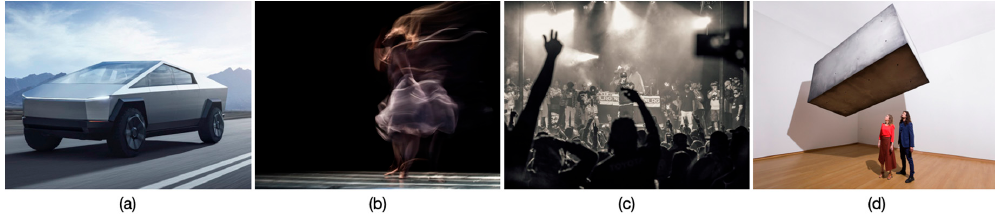
Figure 6. Examples suggested by the participants (Reprinted with permission): ( a ) Tesla cybertruck, ( b ) artist concert performance, ( c ) listening to music, and ( d ) Drifter.